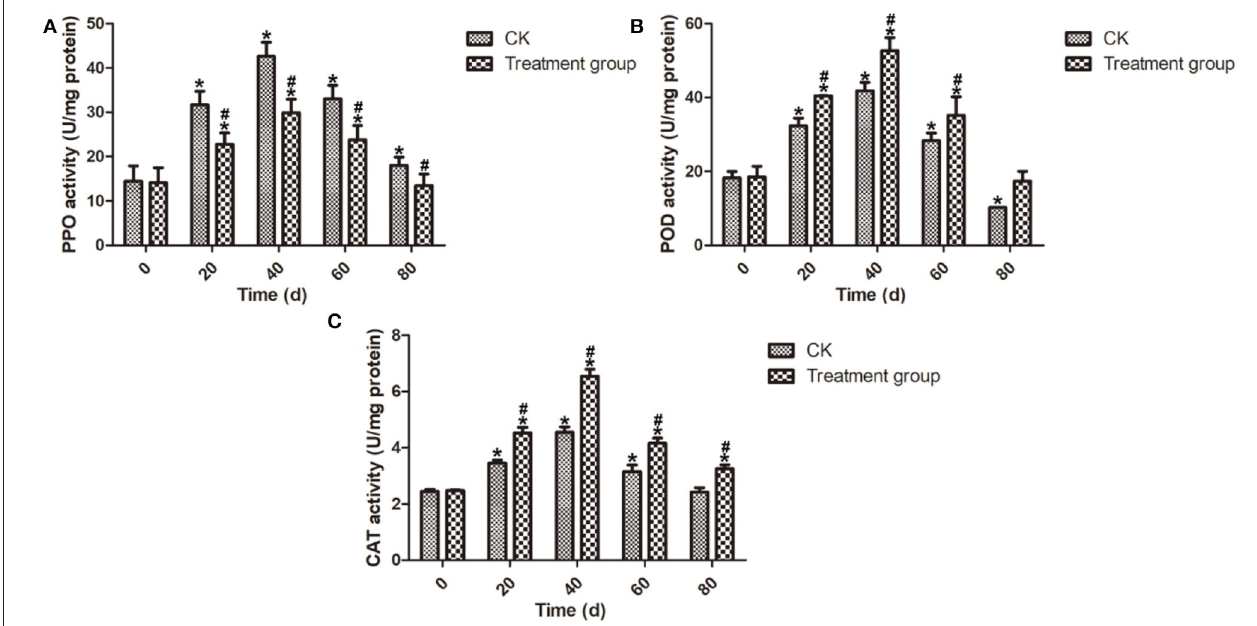
FIGURE 5 | Effects on the enzyme activities of PPO, POD, and CAT of the postharvest blueberries after ozone fumigation treatment. (A) Effect on the PPO activity, (B) effect on the POD activity, and (C) effect on the CAT activity. “*” indicated the decay rates and fruits firmness of ozone fumigation treatment with a significant difference at p < 0.05 compared with the decay rates and fruits’ firmness at 0 d. “#” indicated the inhibition rates of ozone fumigation treatment with a significant difference at p < 0.05 compared with the CK